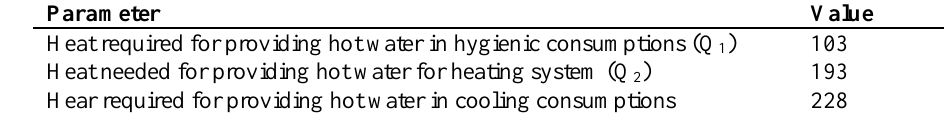
Table 2. Value of cooling and heating thermal load for separate needs in the case study Parameter Value Heat required for providing hot water in hygienic consumptions (Q 1 ) 103